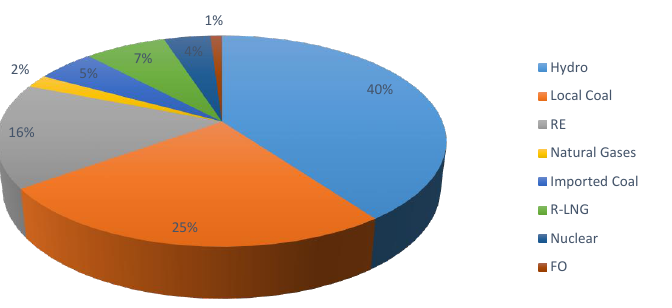
Figure 7. Pakistan’s energy mix by 2040.